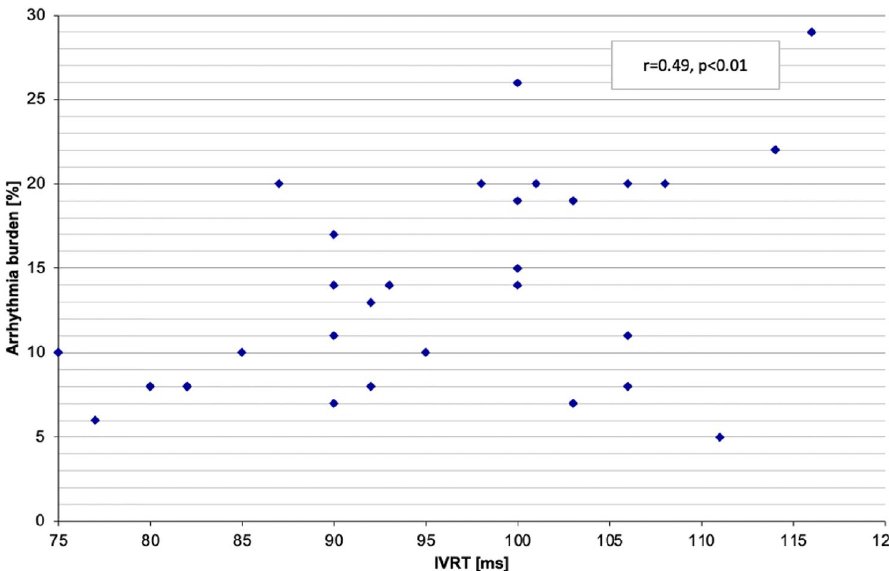
Figure 1. Correlation between the IVRT and the arrhythmia burden. Arrhythmia burden—the percentage of ventricular extra beats in comparison to the number of all beats per 24 h, IVRT—isovolumetric relaxation